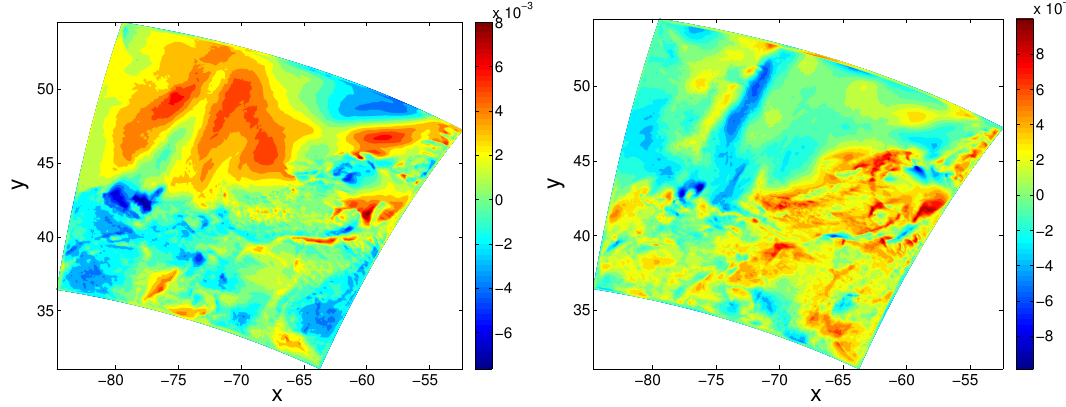
Figure 3. Contour plots of the first ( left ) and second ( right ) POD